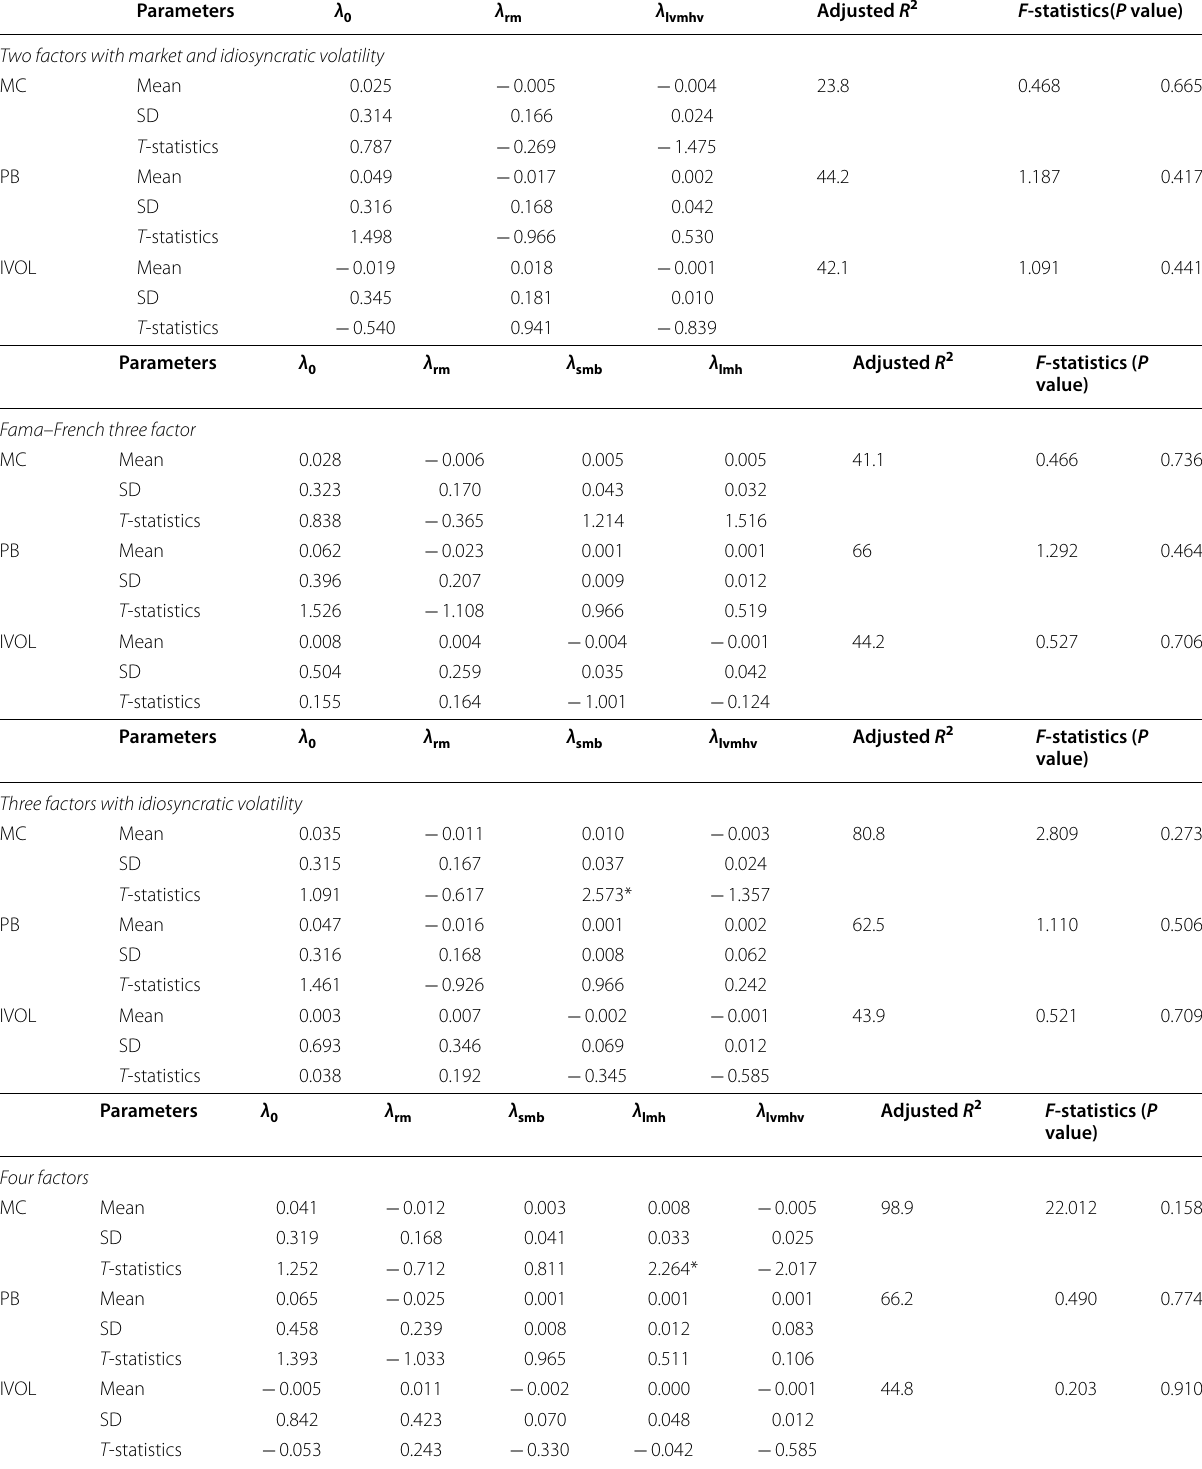
Table 8 Fama–Macbeth’s cross-sectional regression